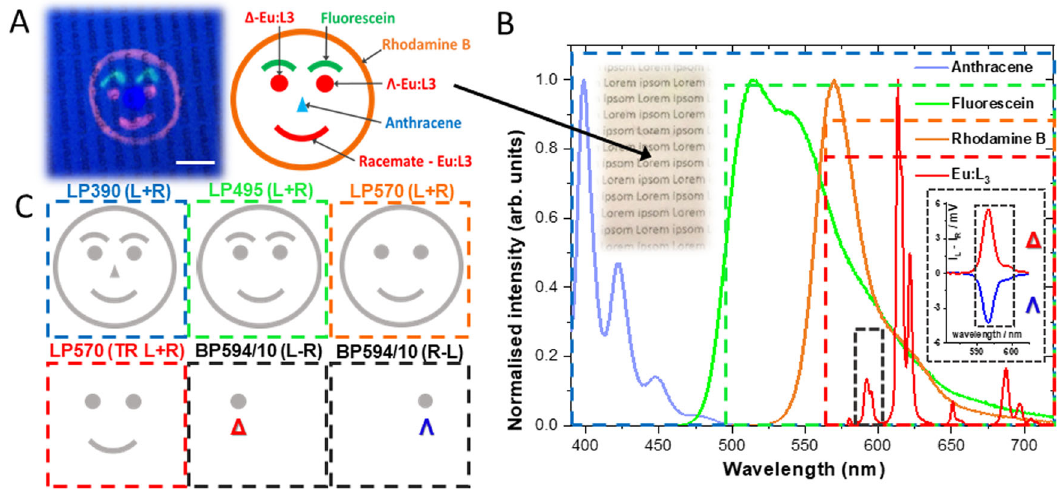
of the POC CSI security tag. One image encodes six different images that can be individually revealed. Chromatic separation can be facilitated using a combination of appropriate bandpass fi ltersand time-resolved(TR) detection asdepicted using CPLP, whilst opposing helicity information can be read out using individual CPL channel detection.